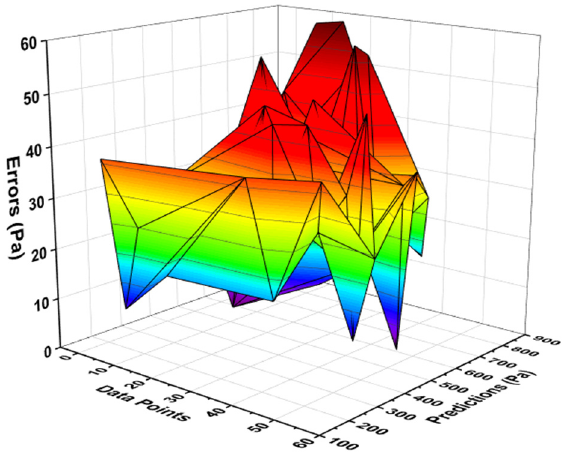
Figure 6. Error distribution of R-F model for yield stress.